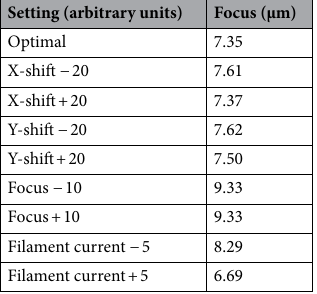
Setting (arbitrary